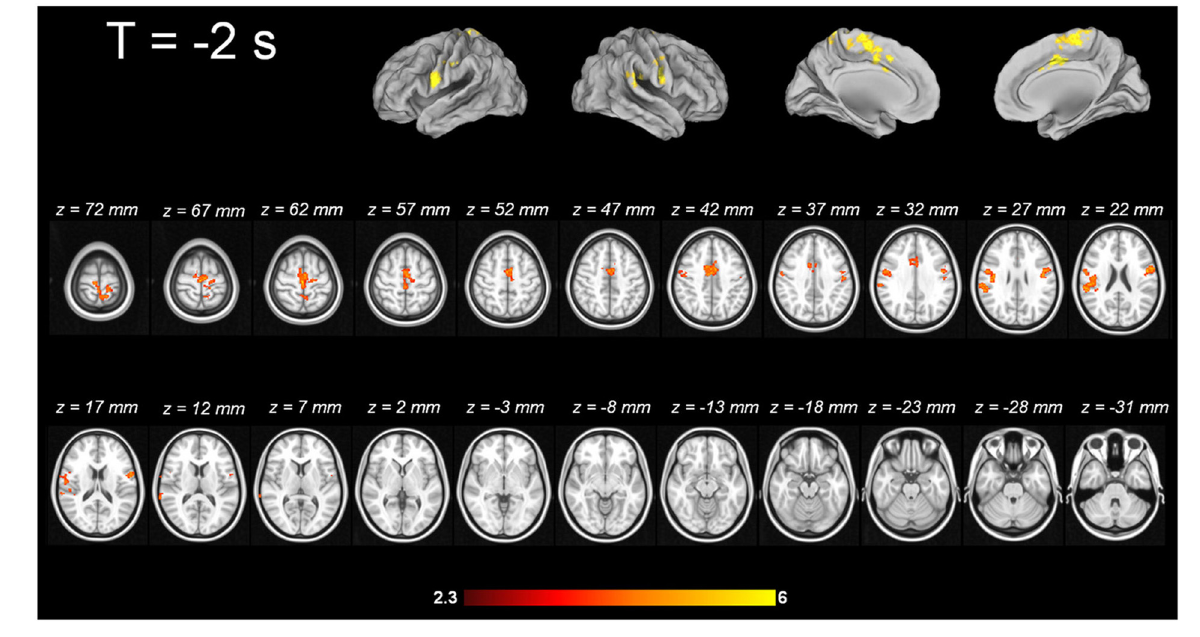
FIGURE 1 | Tic-related activity 2s before tic.